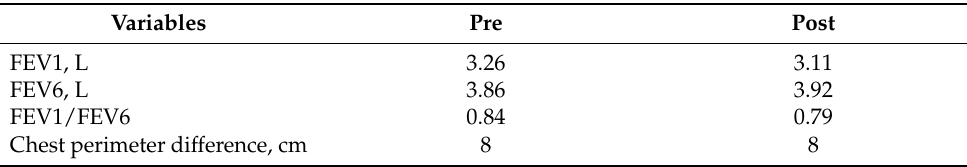
Table 1. Respiratory values before and after the intervention. Variables